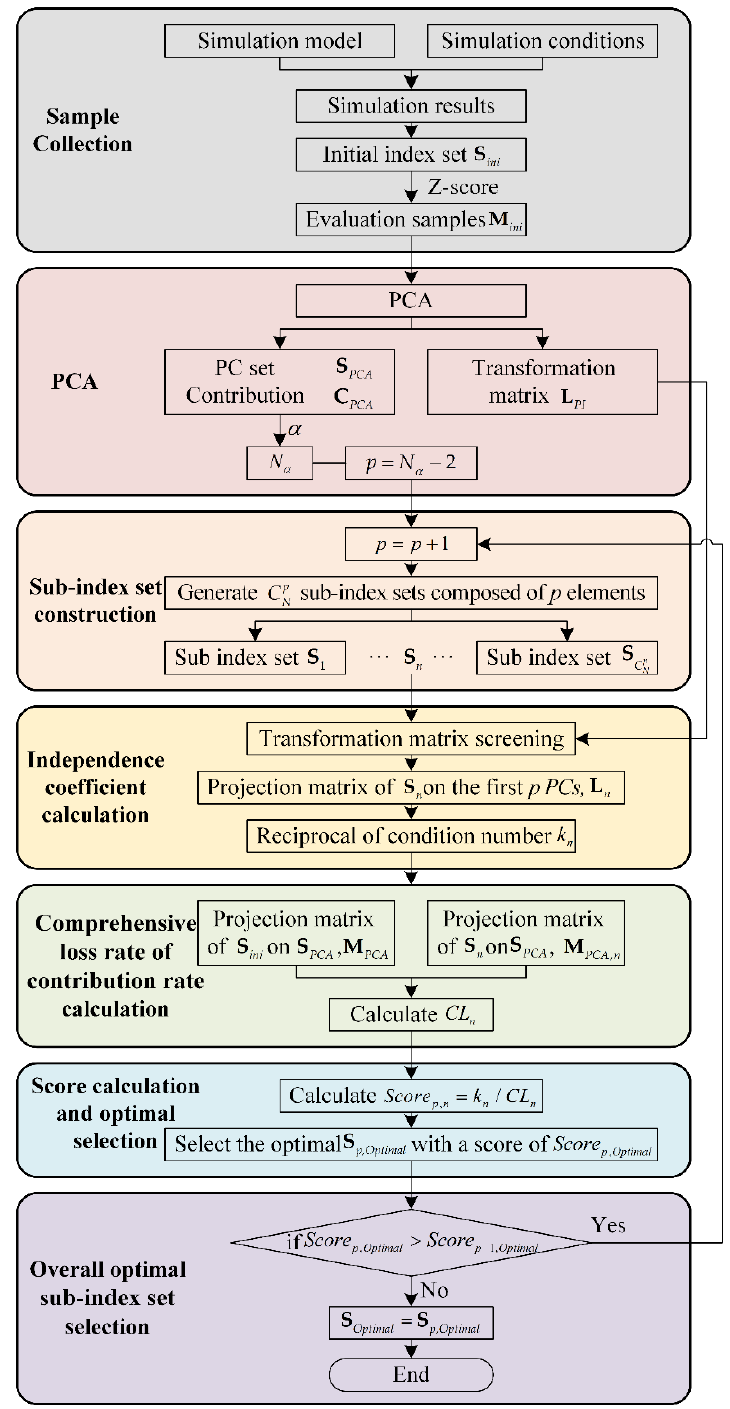
Figure 6. Quantitative screening (ICCLR) process of the index system. Step 1: Sample collection.